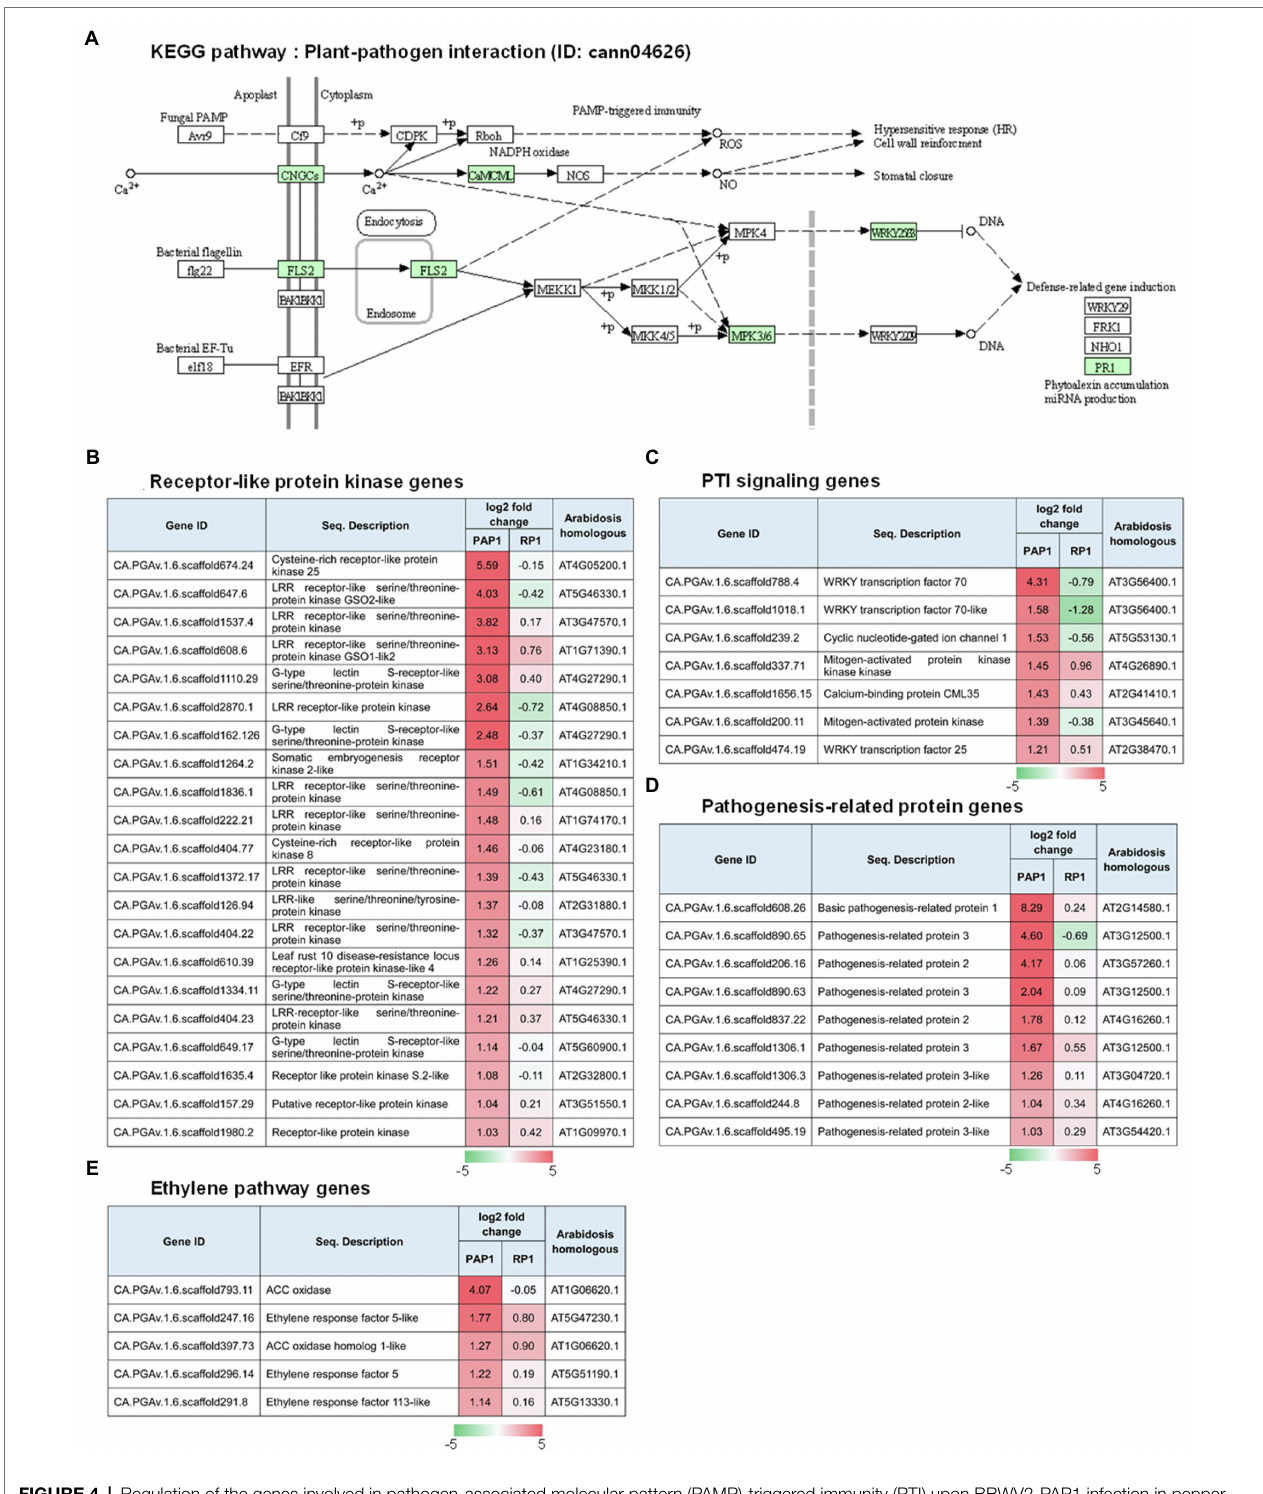
FIGURE 4 | Regulation of the genes involved in pathogen-associated molecular pattern (PAMP)-triggered immunity (PTI) upon BBWV2-PAP1 infection in pepper. (A) Kyoto Encyclopedia of Genes and Genomes (KEGG) pathway enrichment analysis. The DEGs upregulated upon BBWV2-PAP1 infection were mapped to the plant–pathogen interaction KEGG pathway (ID: cann04626). Green boxes represent genes upregulated upon BBWV2-PAP1 infection. (B) Receptor-like protein kinase genes upregulated upon BBWV2-PAP1 infection. (C) DEGs associated with PTI signaling. (D) Pathogenesis-related protein genes upregulated upon BBWV2- PAP1 infection. (E) DEGs associated with the ethylene pathway. The changes in gene expression were calculated using a log scale of the FPKM data obtained by RNA Sequencing. Red and green indicate up and downregulation,